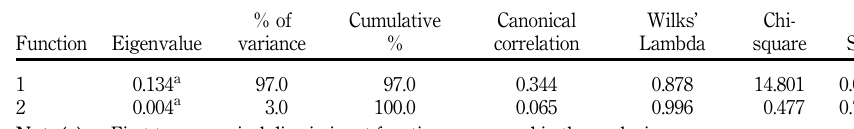
Table 5. Goodness of fit for discriminant